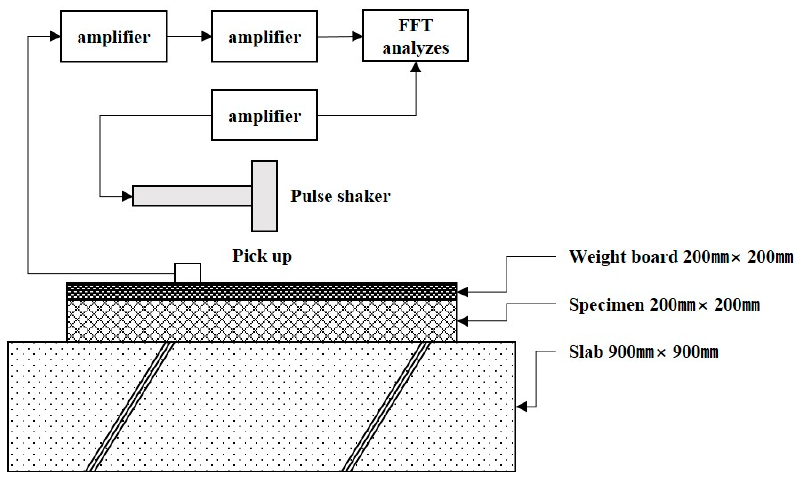
Figure 4. Test method for dynamic stiffness by pulse shaker.